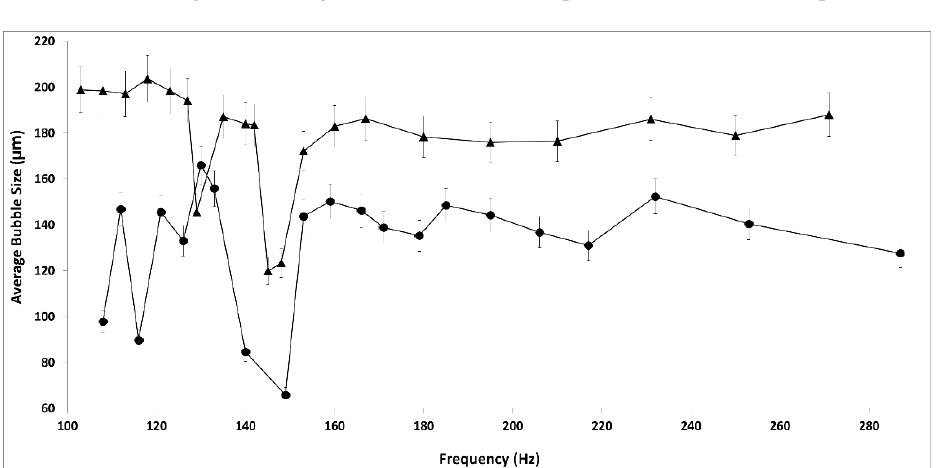
Figure 6. Feedback length vs. average bubble size ( —92 lpm OD4 mm, —0 86 lpm OD 4 mm).